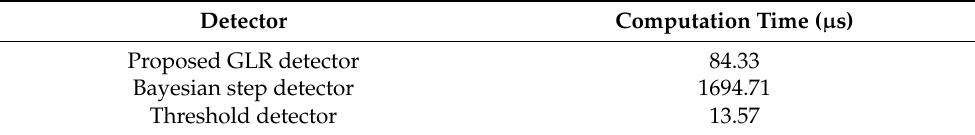
Table 3. Computation